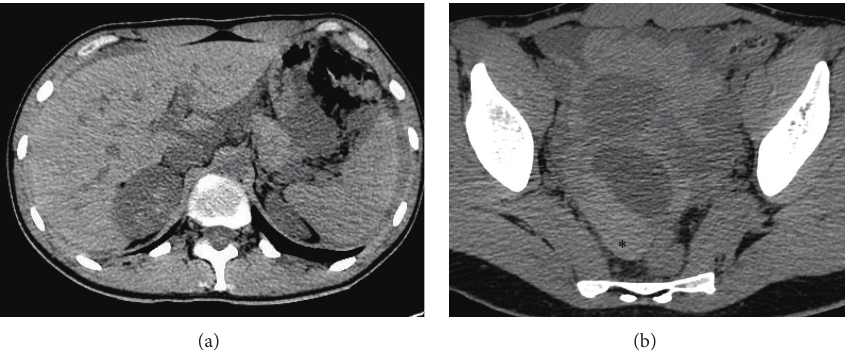
Figure 2: Unenhanced CT axial images (a, b) show diffuse peritoneal effusion in abdomen with different attenuation values that progressively increase from the upper abdomen (a) to the pelvis (b) where it becomes strongly hyperdense (60–65 HU, ∗ ) for the presence of blood component. (b) Low-density cyst is appreciable in the right adnexal